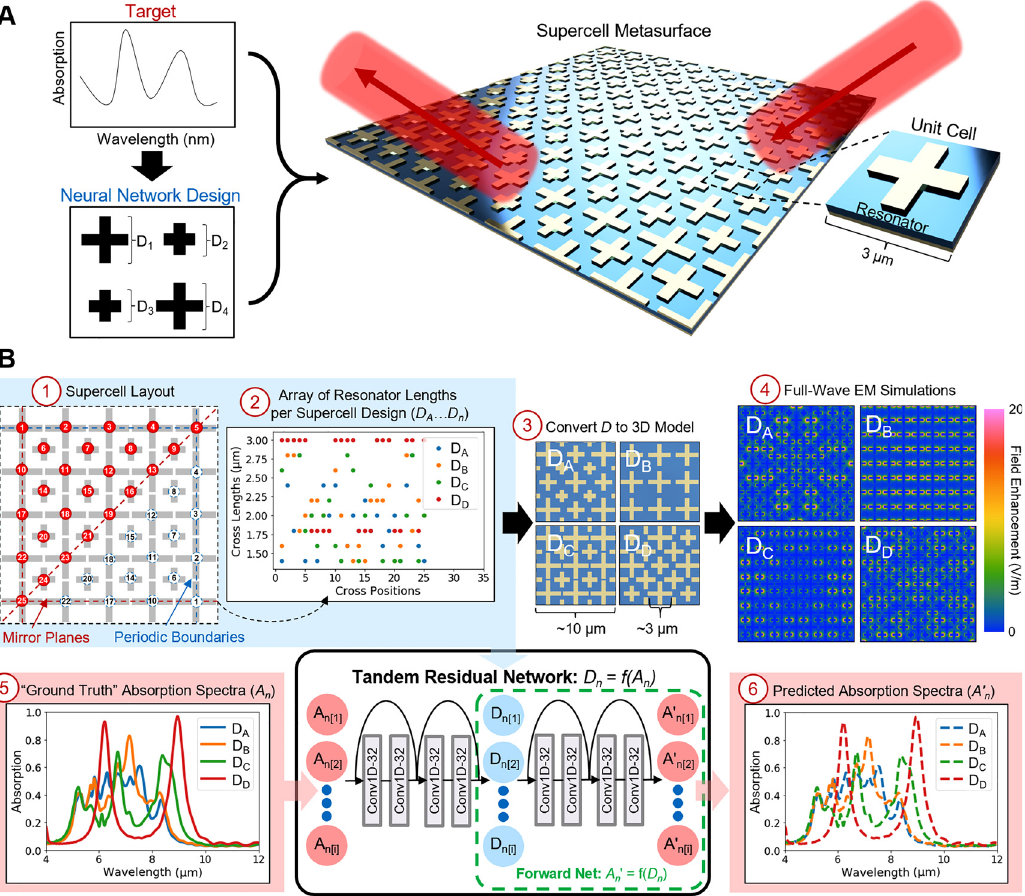
Figure 1: Inverse design of supercell metasurfaces with a range of underlying symmetries using a tandem residual network approach. (A) A target absorption spectrum is defined, and the matching design parameters for a multiplexed array of metal – insulator – metal (MIM) resonators are generated. (B) Data preparation schematic for deep learning. Supercell design parameters (1) representing resonator lengths andpositions(2)areconvertedinto3Dmodels(3).Full-waveelectromagneticsimulationsareperformedonthemodels(4).Designparameters along with corresponding “ ground truth ” (5) and predicted (6) absorption spectra are used to train the tandem residual